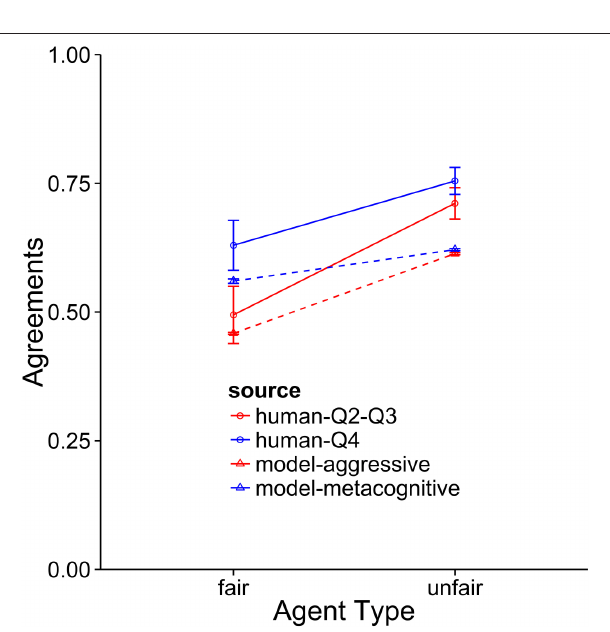
FIGURE 10 | A comparison of the aggressive and metacognitive models to human data with respect to agreements reached. Separate lines represent groups of humans or model